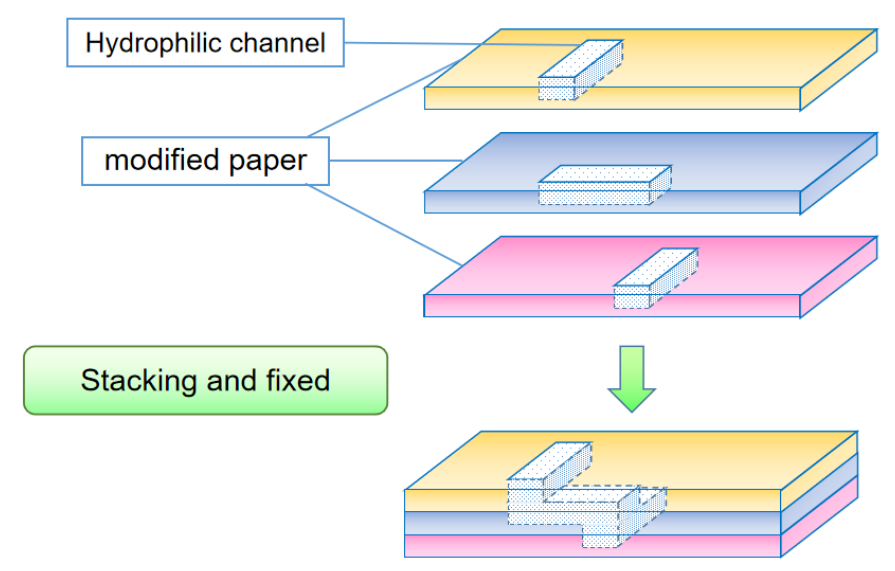
Figure 4. Schematic diagram of 3D paper chip prepared by lamination method.